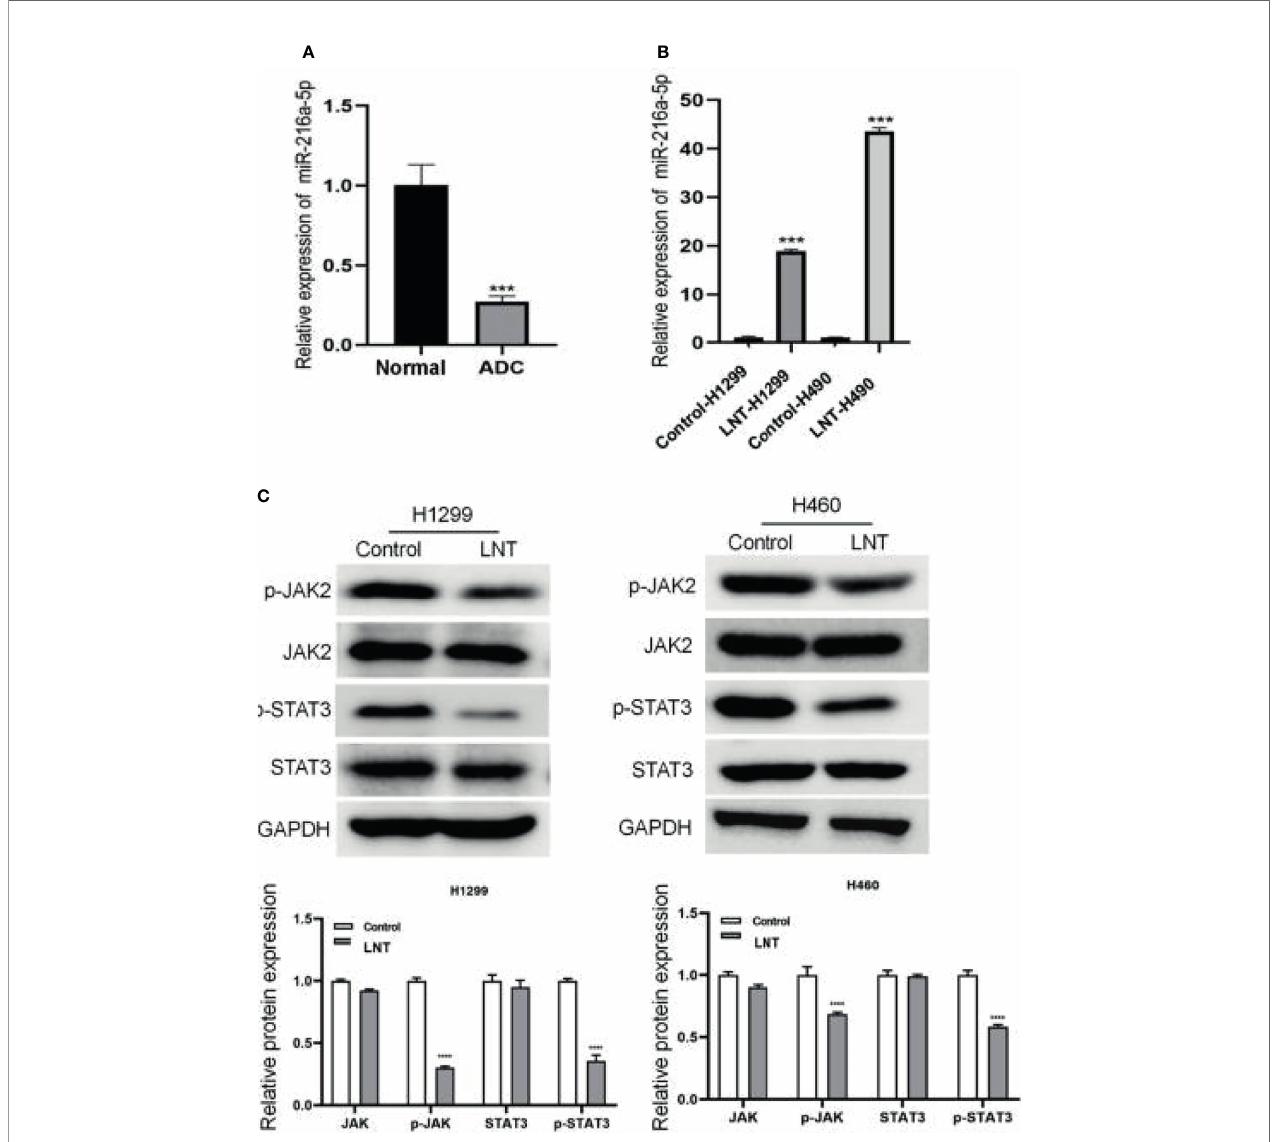
FIGURE 3 | LNT effects on miR-216a-5p and JAK2/STAT3 signaling pathway. (A) miR-216a-5p expression in human lung adenocarcinoma tissues and adjacent normal tissues by qRT-PCR; Per group n = 15. (B) qRT-PCR was used to measure the miR-216a-5p expression in H1299 and H460 cell; (C) Western blot was performed to detect JAK2/STAT3 signaling pathway related protein expression in H1299 and H460 cells. ***P < 0.001 and ****P < 0.0001 vs . control